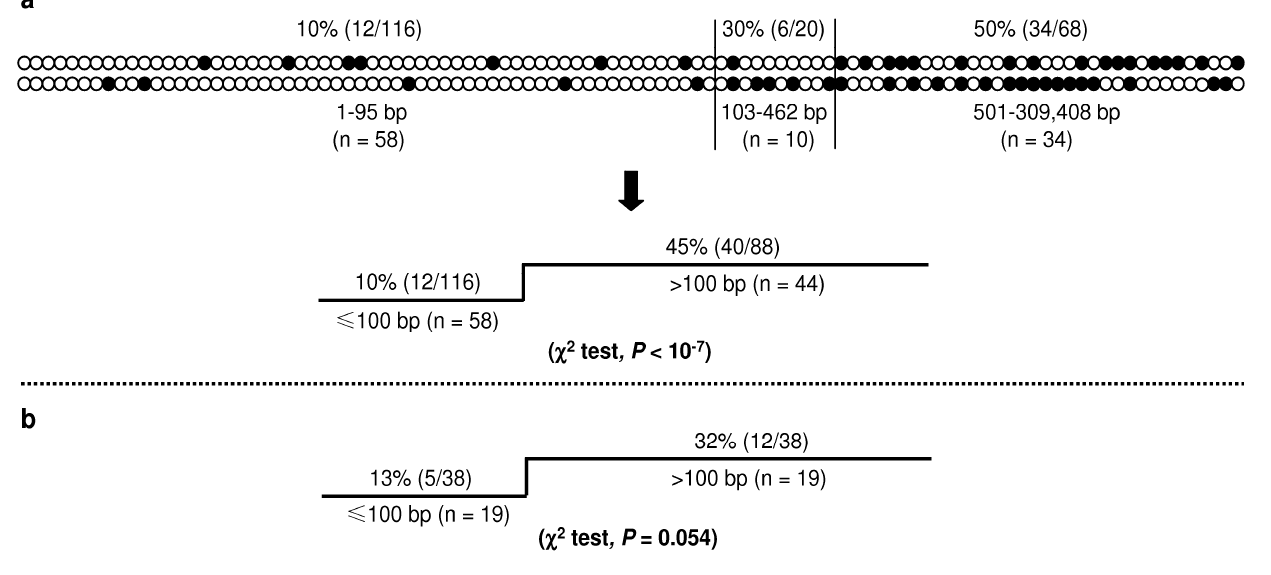
Figure 5. CpG substitutions in double single nucleotide substitution (SNS) mutations. ( a ) Top panel illustrates the distribution of CpG substitutions in 102 pathogenic double SNS mutations. Each pair of vertical circles indicates a double SNS mutation. The upper and lower circles indicate the first and second components of a given double mutation, respectively. Solid circles indicate CpG substitutions. The lower panel compares the proportion of CpG substitutions in the group of ≤ 100 bp with that in the group of >100 bp; ( b ) Proportion of CpG substitutions in the group of ≤ 100 bp with that in the group of >100 bp; data were derived from a re-analysis of all double SNS mutations obtained from the Big Blue mice [17,18]. Reprinted from